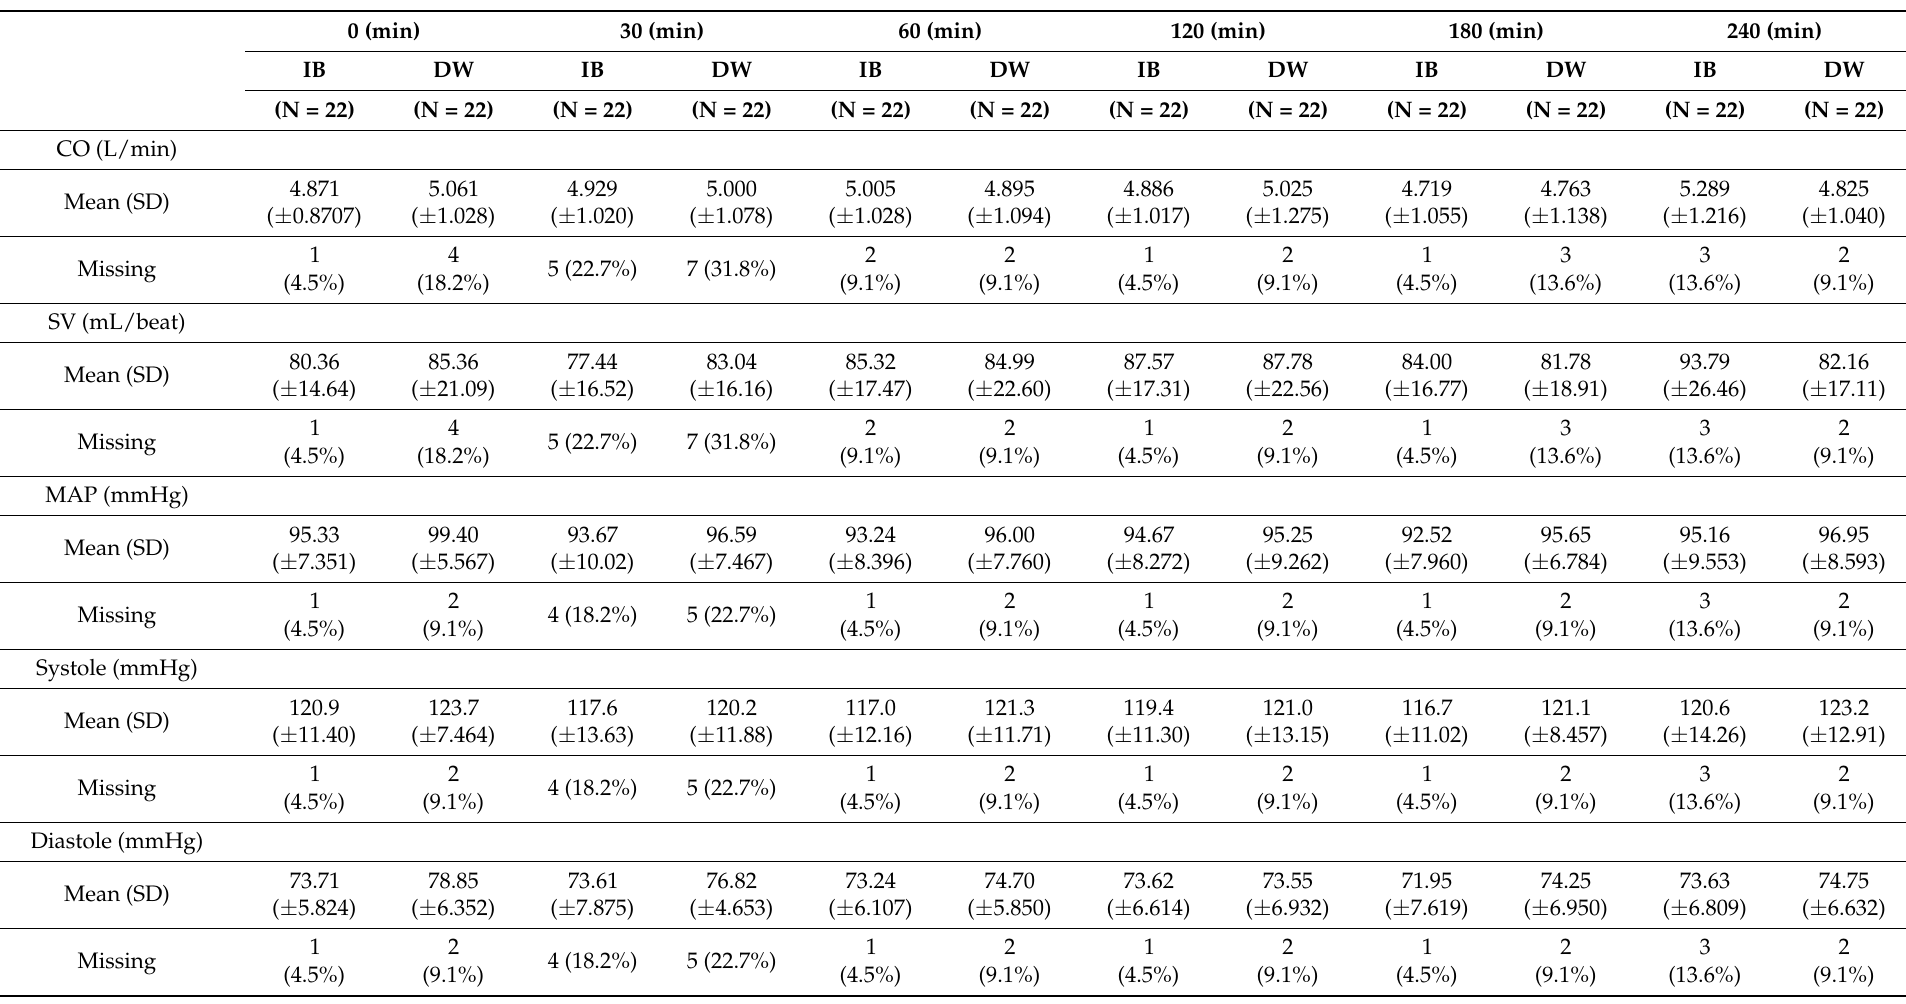
Table 3. Differences in cardiovascular and cardiac autonomic measures throughout the 240 min post ingestion of either the isotonic beverage (IB) or distilled water (DW). * Denotes a significant Drink x Time interaction, p <